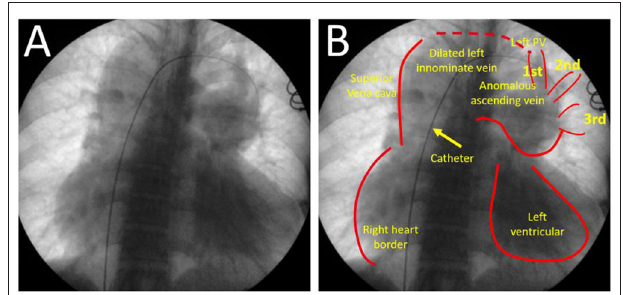
FIGURE 3 | Cardiac catheter angiogram (A,B) from femoral vein approach. It presented pulmonary veins drained into the collecting vein, and then join to form an anomalous vertical vein into left innominate vein and superior vena cava.